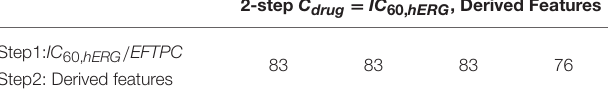
= CM1 and CM3. Row reporting the maximum accuracies obtained using the derived features is reported for comparision with the direct features. ion-channels did not improve classification scores for these